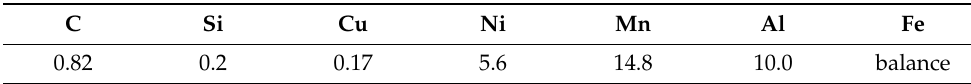
Table 1. Chemical composition of the